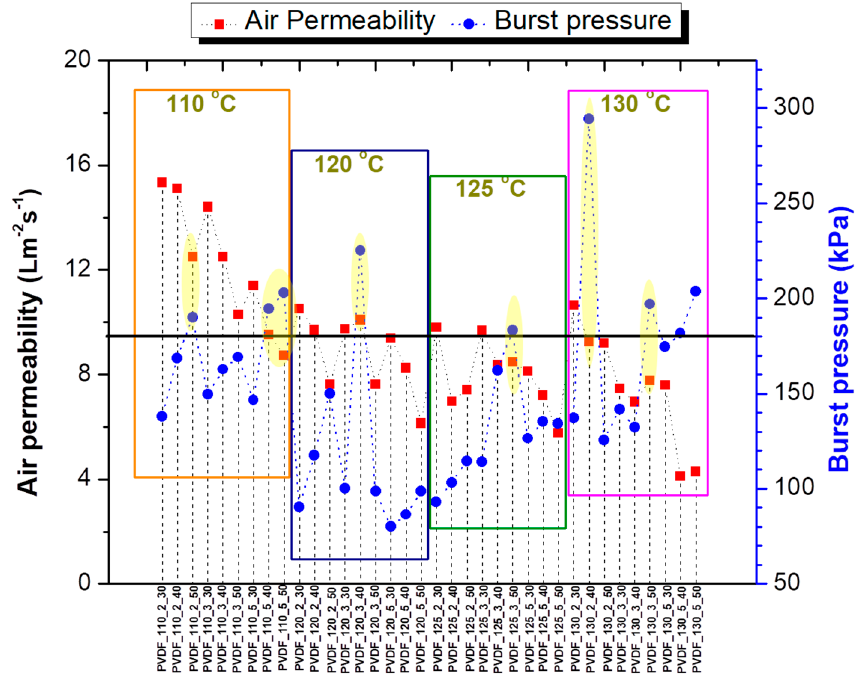
Figure 6. Determination of membranes for filtration application.